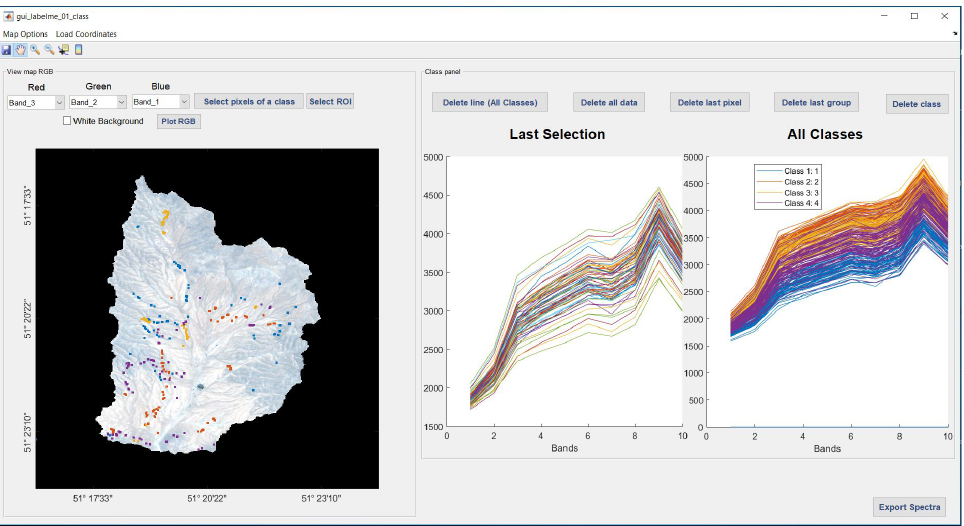
Figure 3. The LabelMeClass tool for extracting labeled data from